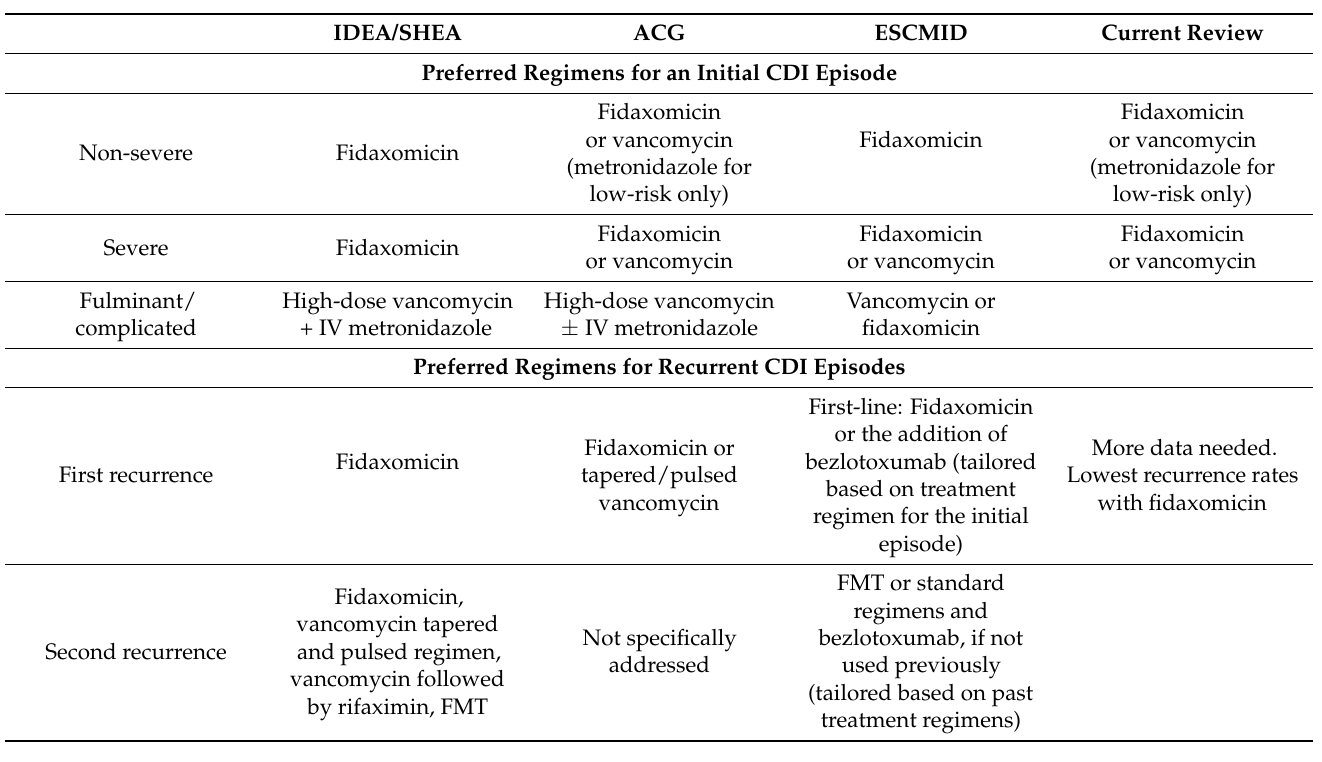
Table 1. Treatment Strategies for